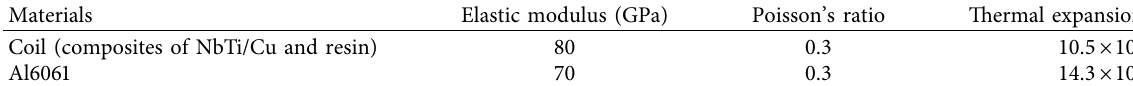
Table 3: Material properties for CCT quadrupole structure analysis.